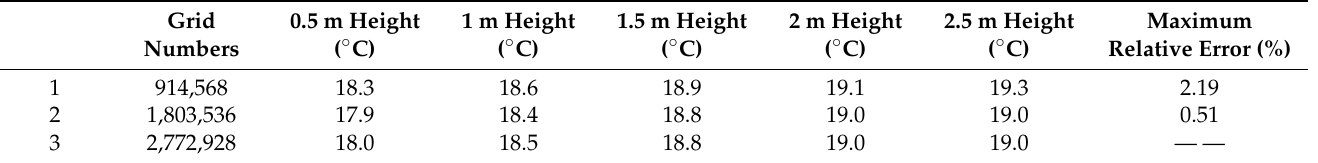
Table 3. Grid independence